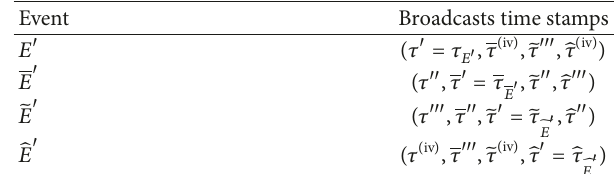
Table 6: The events 𝐸 耠 , 𝐸 stamps received at 𝑈 푟